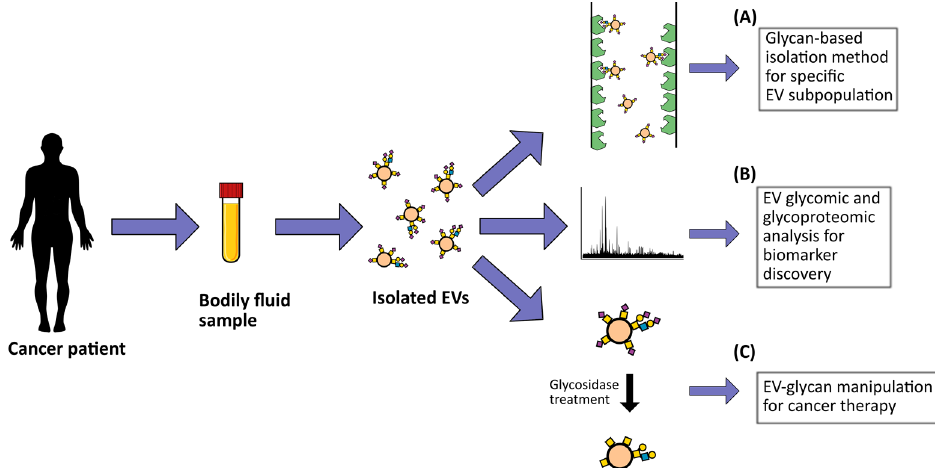
Figure 2. Potential clinical applications of extracellular vesicle (EV) glycosylation. These include ( A ) development of glycan-based EV detection and capture methodologies; ( B ) EV biomarker dis- covery for cancer diagnostic, prognostic and/or patient stratification based on EV glycomic and glycoproteomic profiling; ( C ) development of potential novel cancer therapy strategies through the manipulation of EV glycosylation surface.